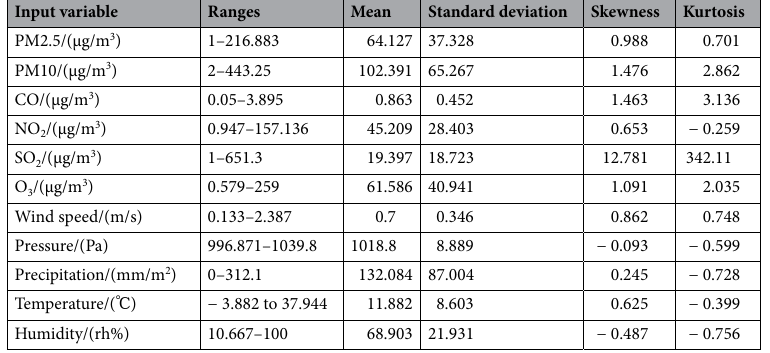
Table 1. Descriptive statistics of pollutant concentrations and meteorological parameters measured by national control points and self-built points.